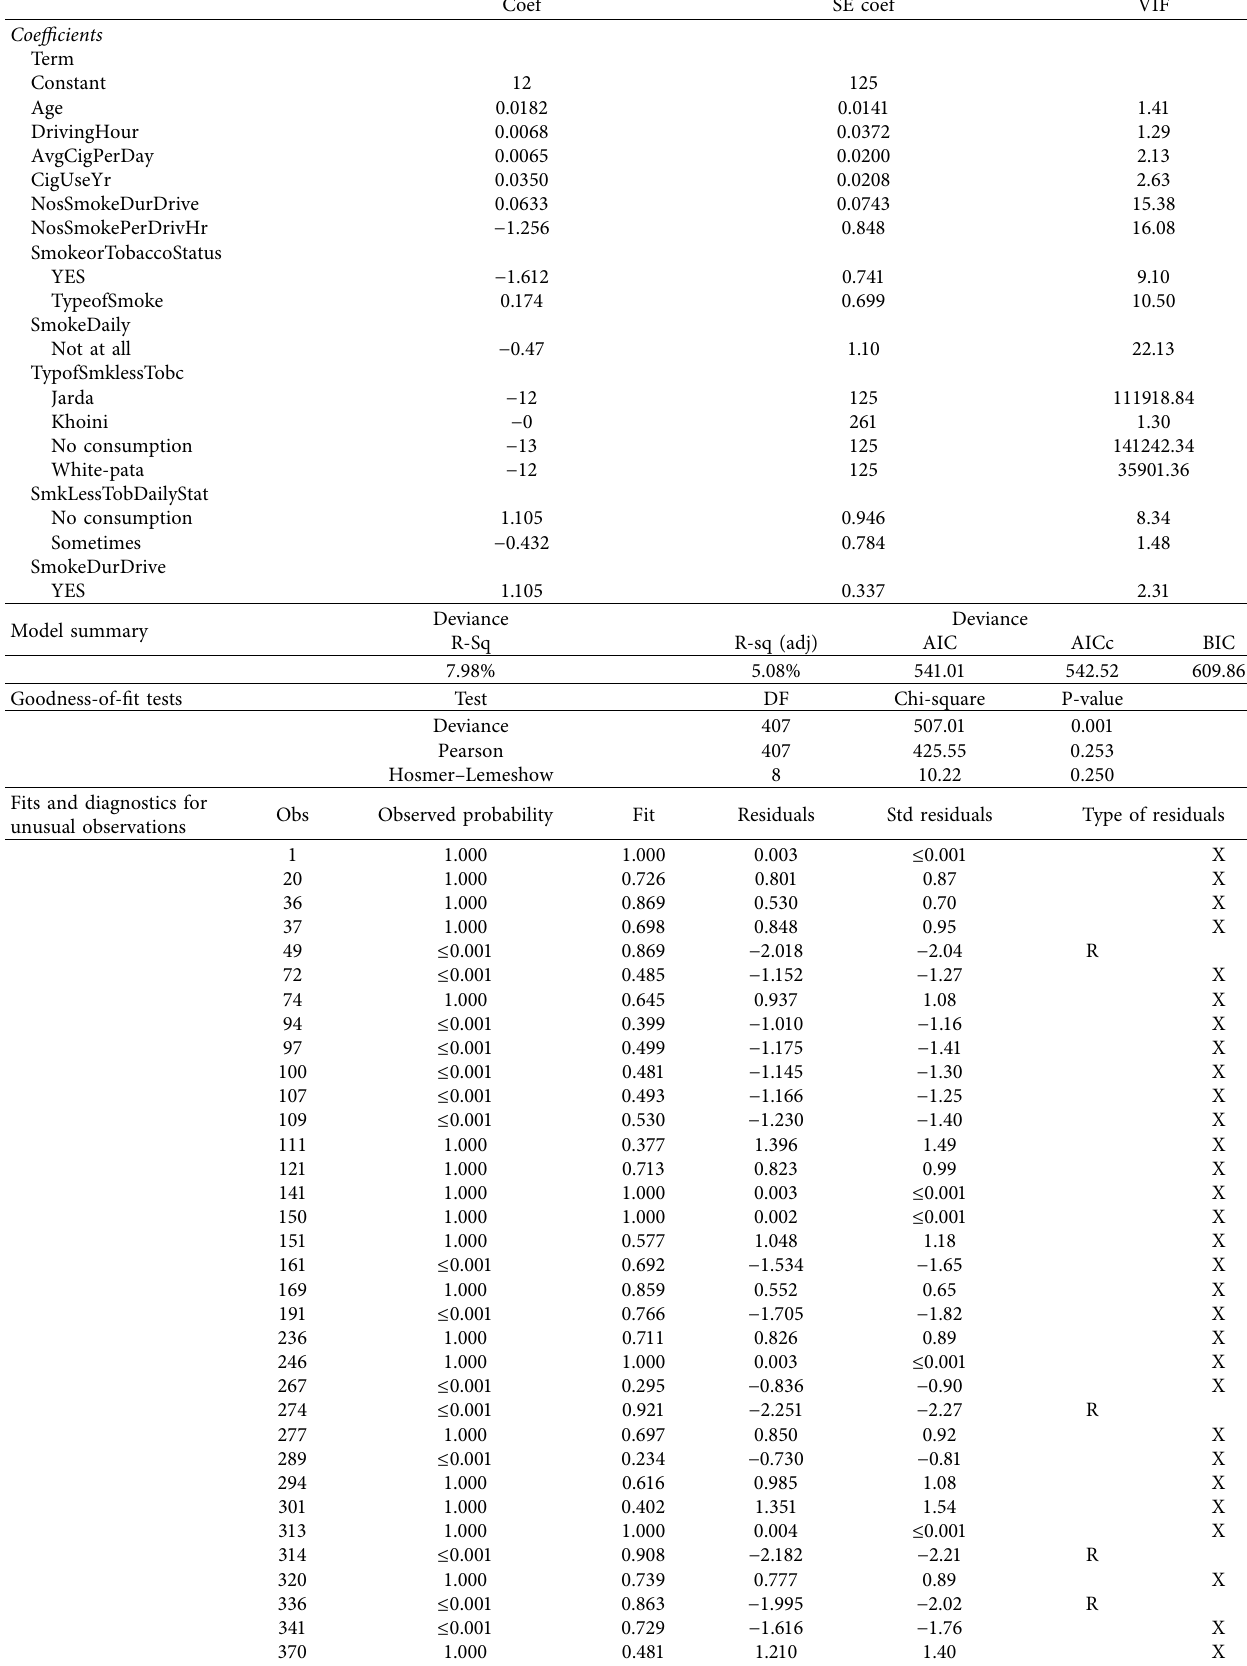
Table 6: Coefcients, model summary, goodness-of-ft tests of the regression, and fts and diagnostics for unusual